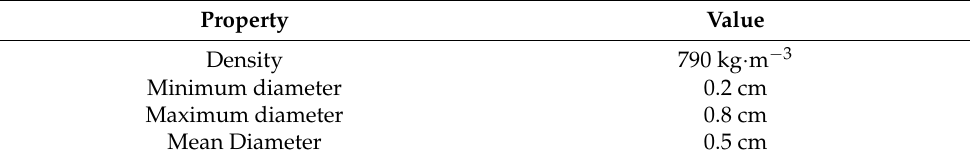
Table 4. Solid-phase